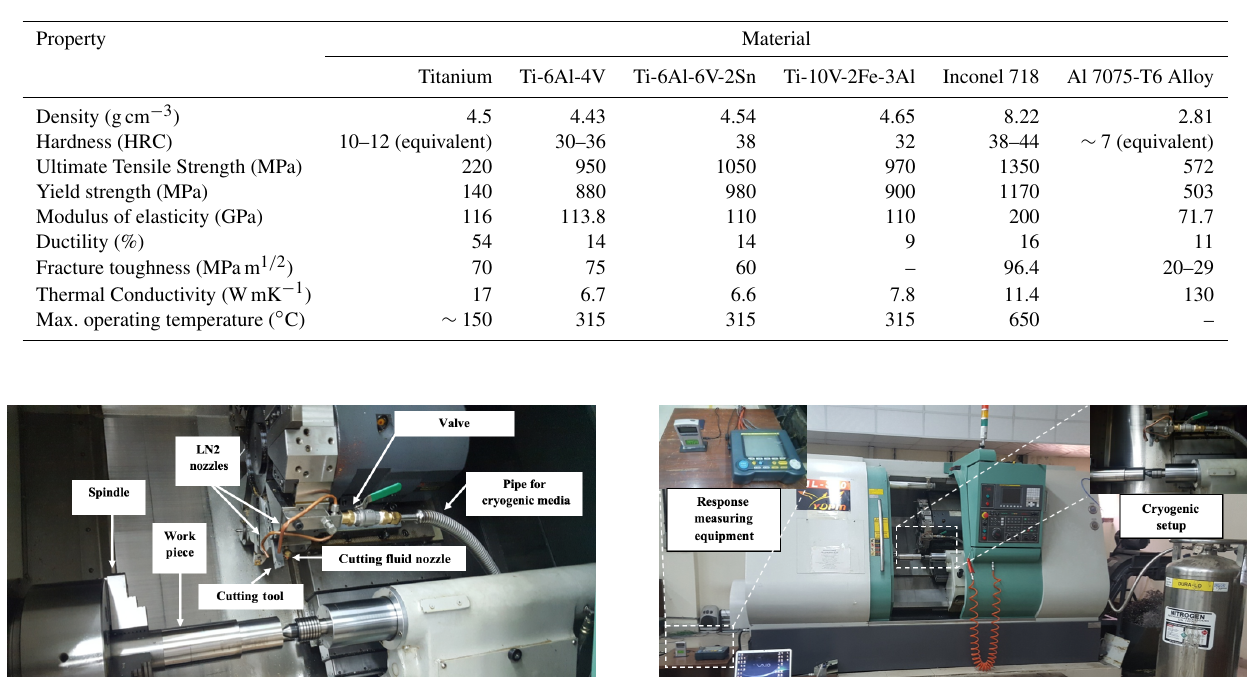
Table 1. Comparison of aerospace alloys properties (Jaffery et al., 2015).